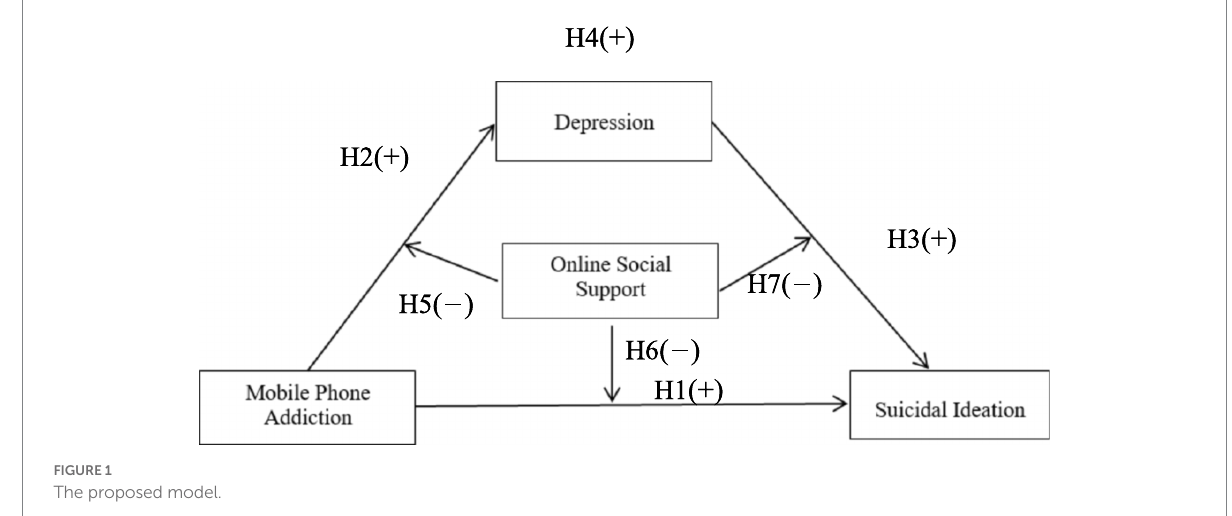
FIGURE 1 The proposed